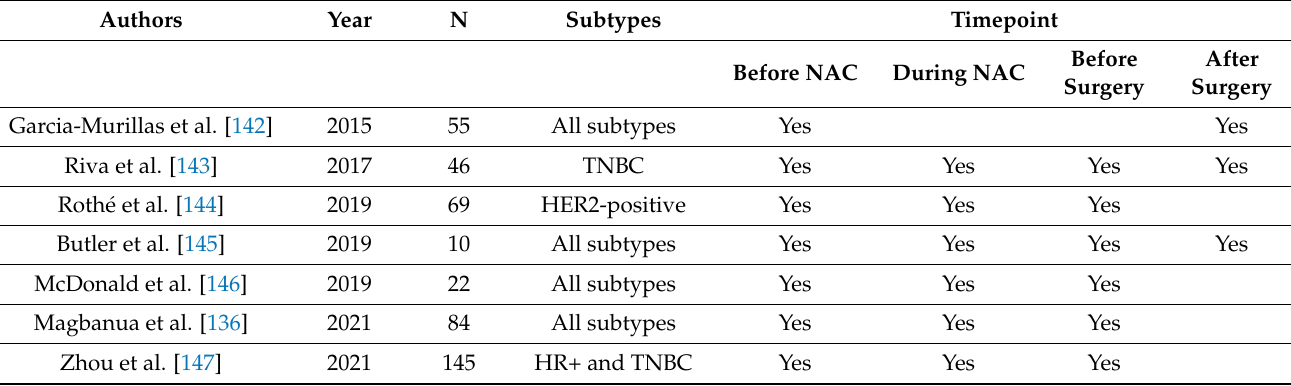
Table 3. Studies evaluating ctDNA in early breast